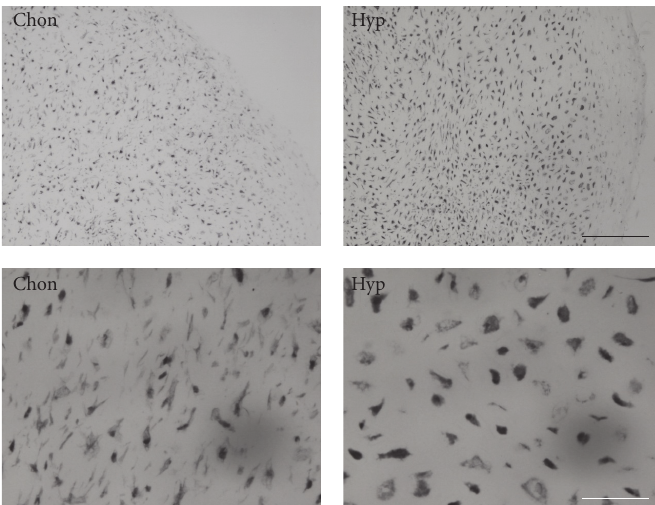
Figure 5: Immunohistochemical staining of BMP4 of day 28 MSC pellets. BMP4 protein staining is increased under hypertrophy (hyp) enhancing conditions as compared to chondrogenic (chon) conditions. Black scale bar = 200 𝜇 m; white scale bar = 50 𝜇 m.